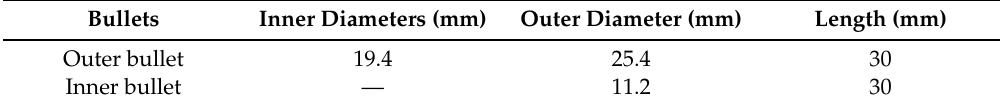
Figure 3. Schematic diagram ( a ) and experimental setup ( b ) for the impact measurement system using a home-made dual-warhead Hopkinson bar for dynamic linearity increment with a high measurement range. ( c ) Close-up of the measured system comprising a target accelerometer, its mounted seat, and grating. ( d ) Close-up of the launch system comprising inner and outer bullets. The outer and inner launch tube and are marked by red circles in ( b ), respectively. Table 1. Parameters of the